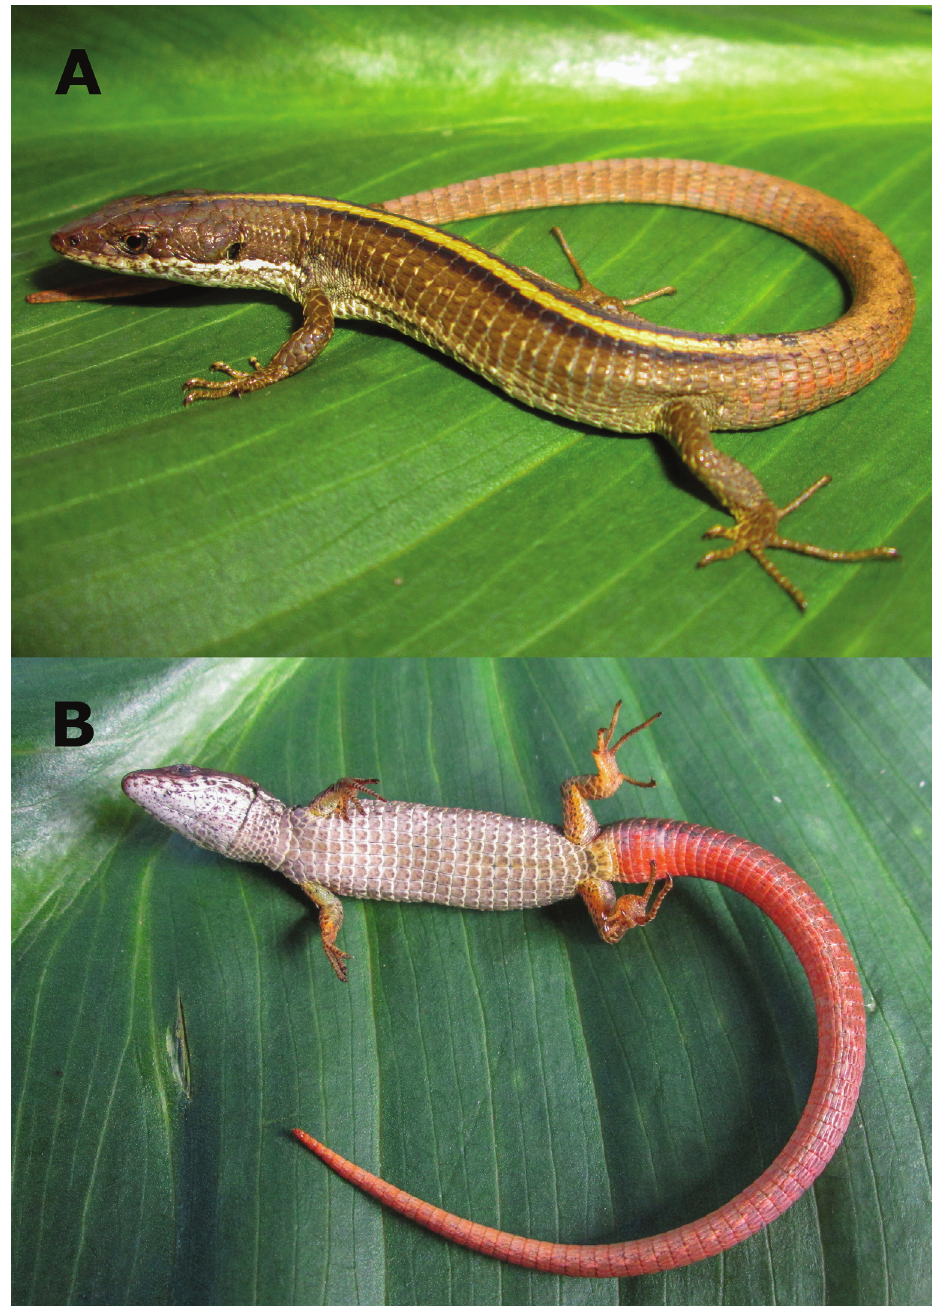
Figure 2. Dorsolateral ( A ) and ventral ( B ) views of Selvasaura evasa sp. nov. holotype, CORBIDI 15119, in life. Photographs by L.Y.